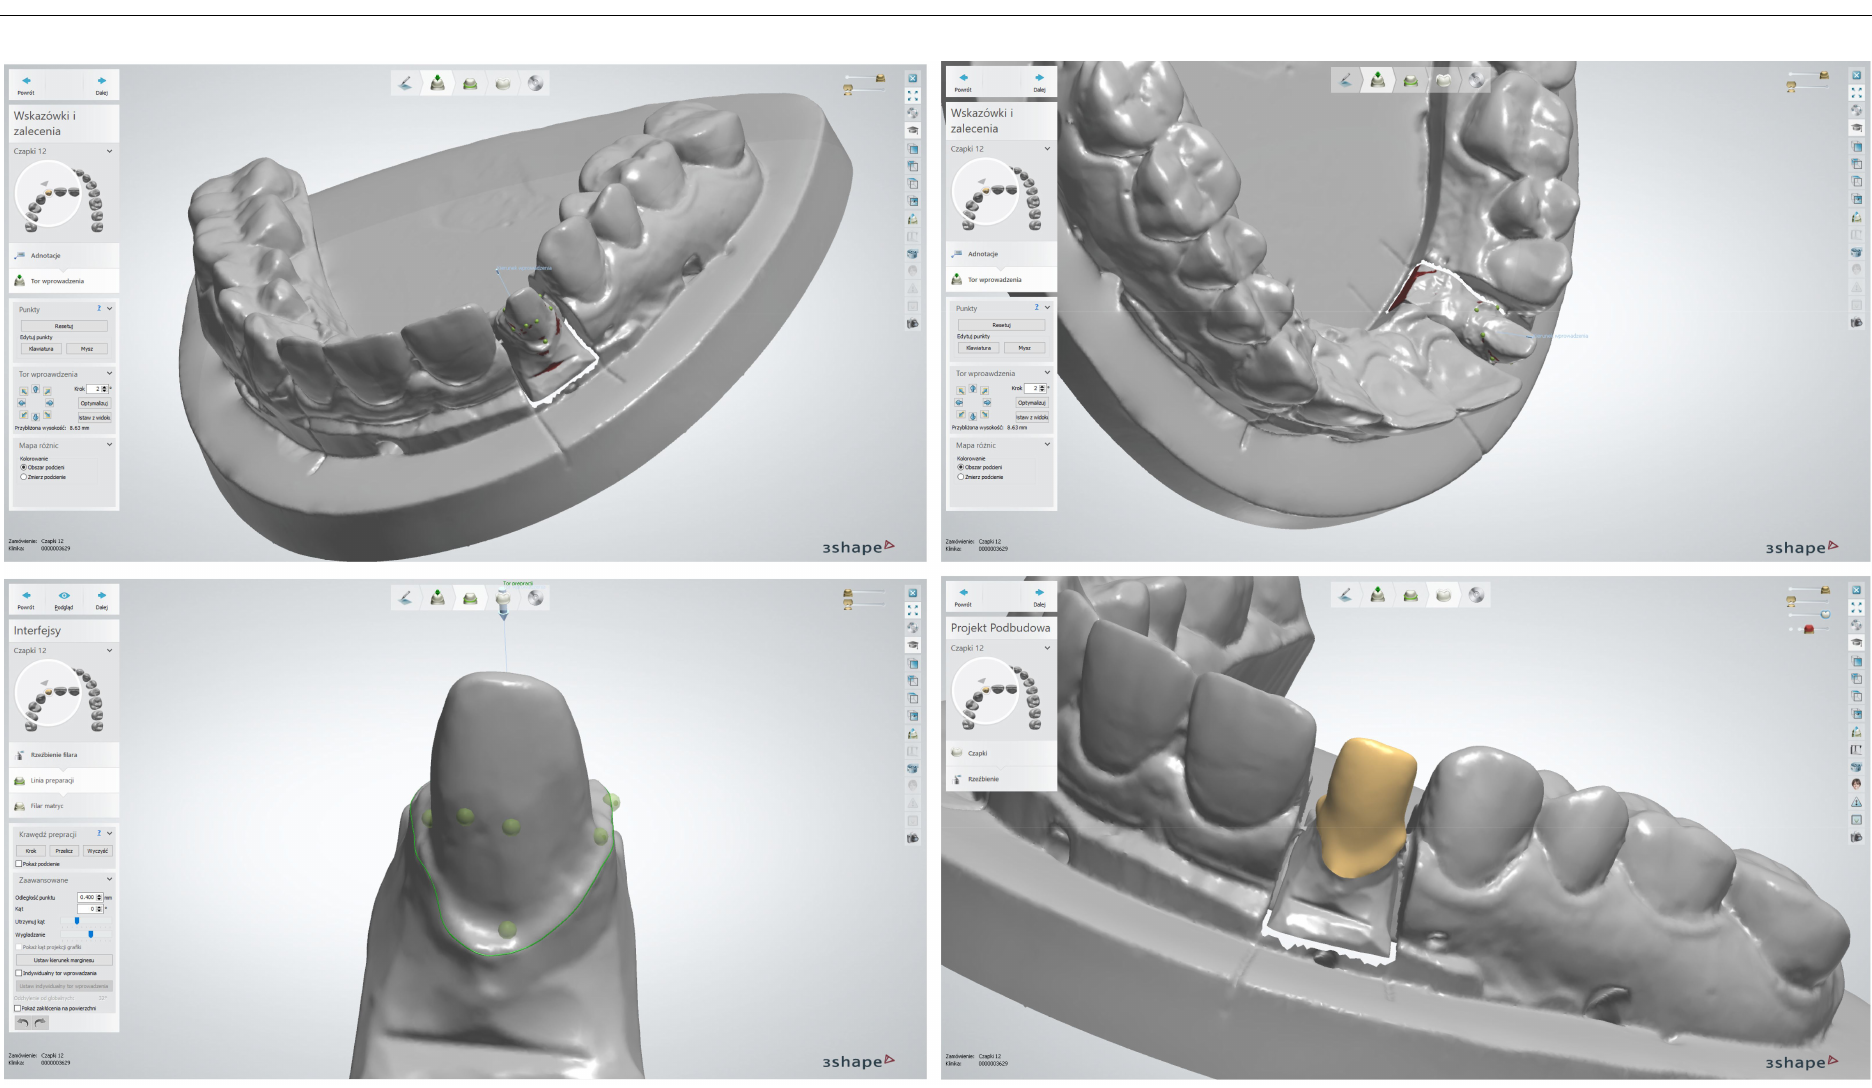
Figure 3. Abutment scanning and substructure design in the 3Shape Dental System clinical